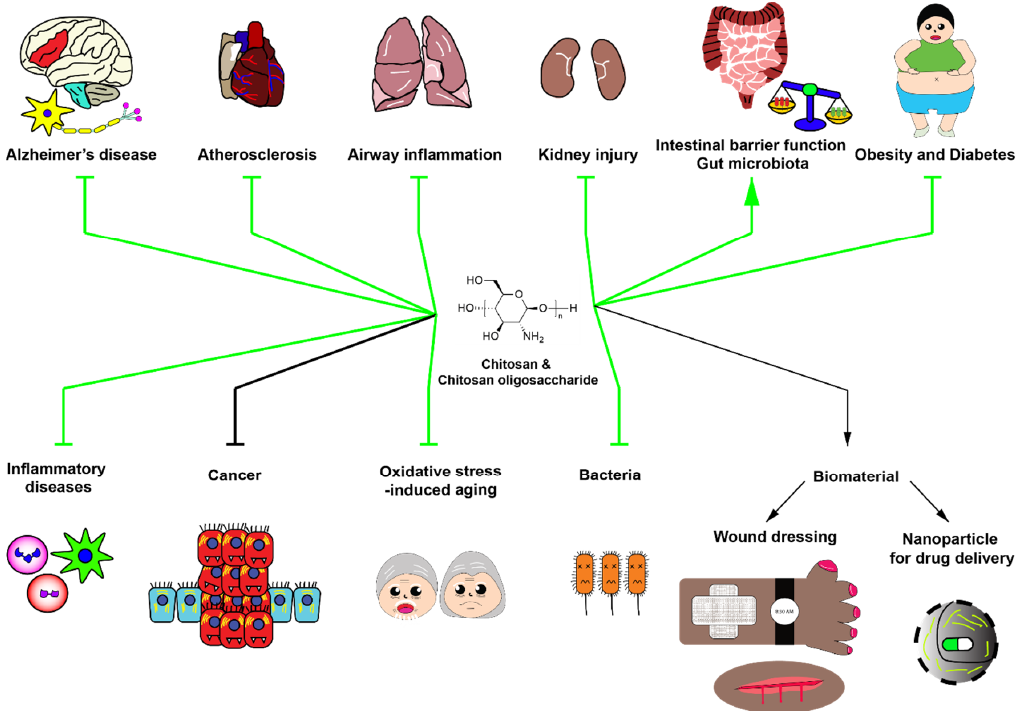
Figure 2. Potential roles of chitosan and chitosan oligosaccharide in biomedical applications. Green arrows indicate the beneficial applications of chitosan and chitosan oligosaccharide with strong evidence. Black arrows indicate the potential effects of chitosan and chitosan oligosaccharide with slight evidence. Chitosan and chitosan oligosaccharide have numerous beneficial effects including anti-Alzheimer’s disease, anti-atherosclerosis, anti-inflammatory diseases, kidney injury alleviation, improvement of intestinal barrier function, enhancement of beneficial gut microbiota, alleviation of obesity and type II diabetes, prevention of inflammatory diseases, anticancer activity, antiaging activity and antibacterial activity, and serve as valuable biomaterials for wound dressing and drug delivery.